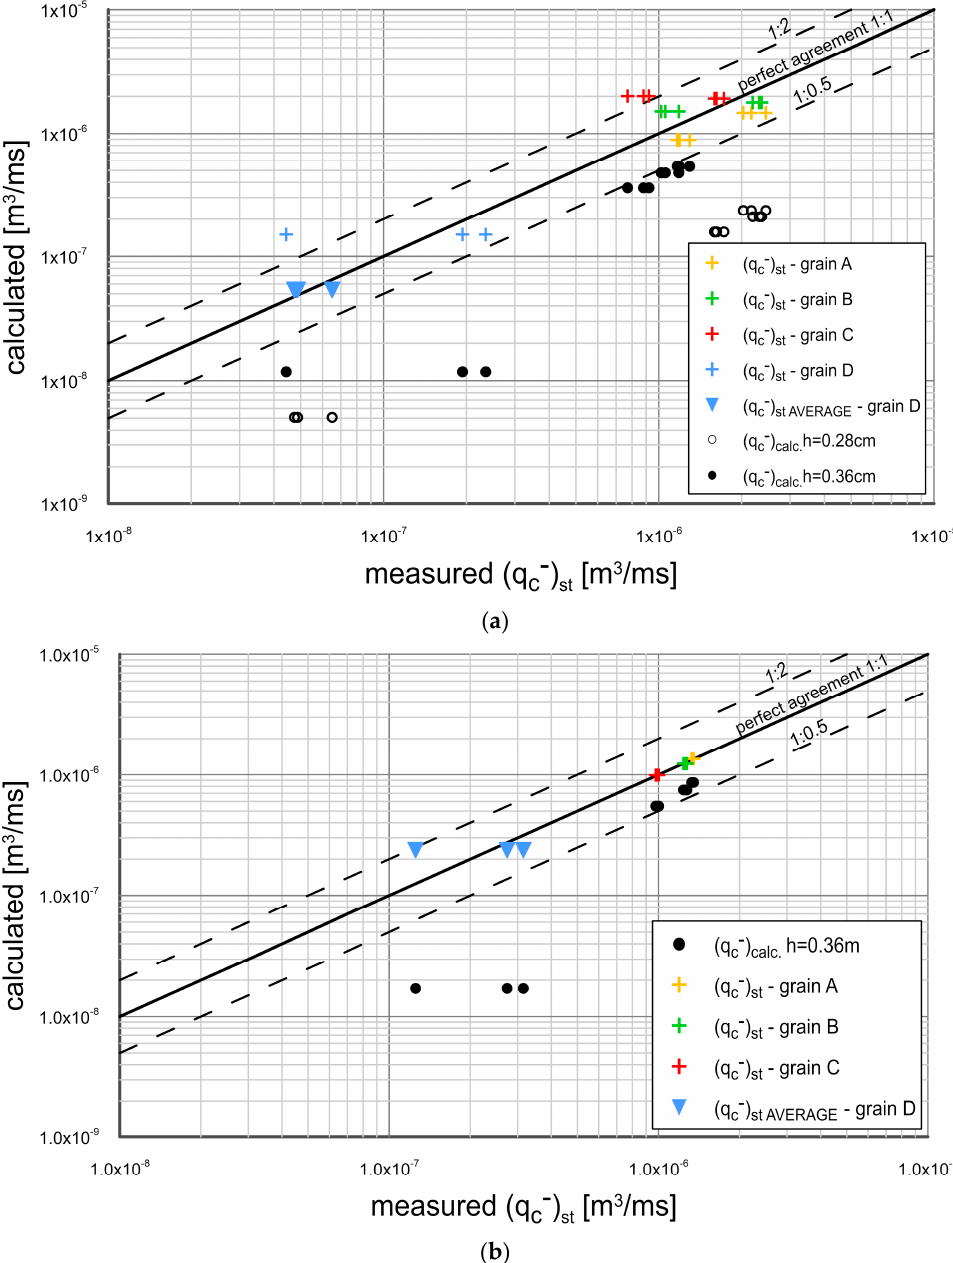
Figure 11. Comparison of calculation and measurements results q − c between flat ( a ) and sloped bed ( b ) cases during the trough.